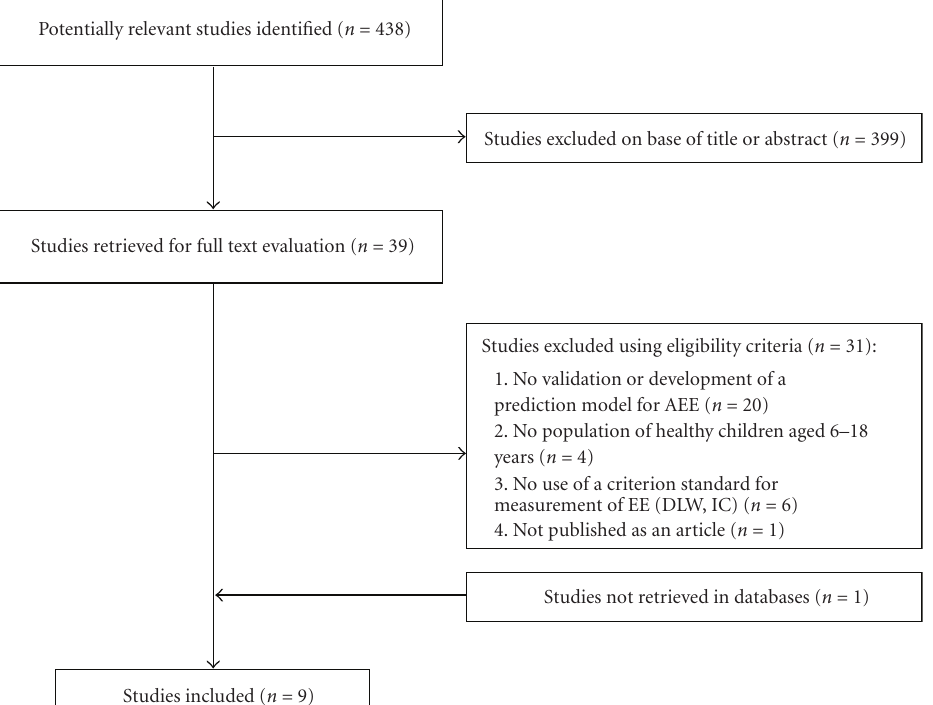
Figure 1: Selection process for studies included in the